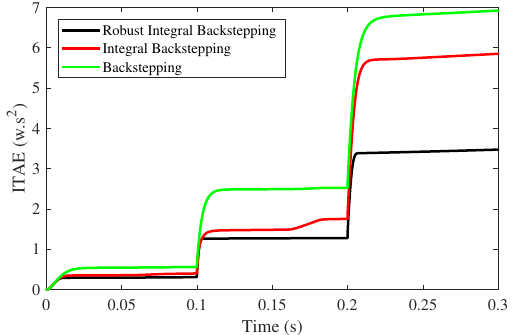
Figure 22. ITAE for multiple uncertainties under varying irradiance and